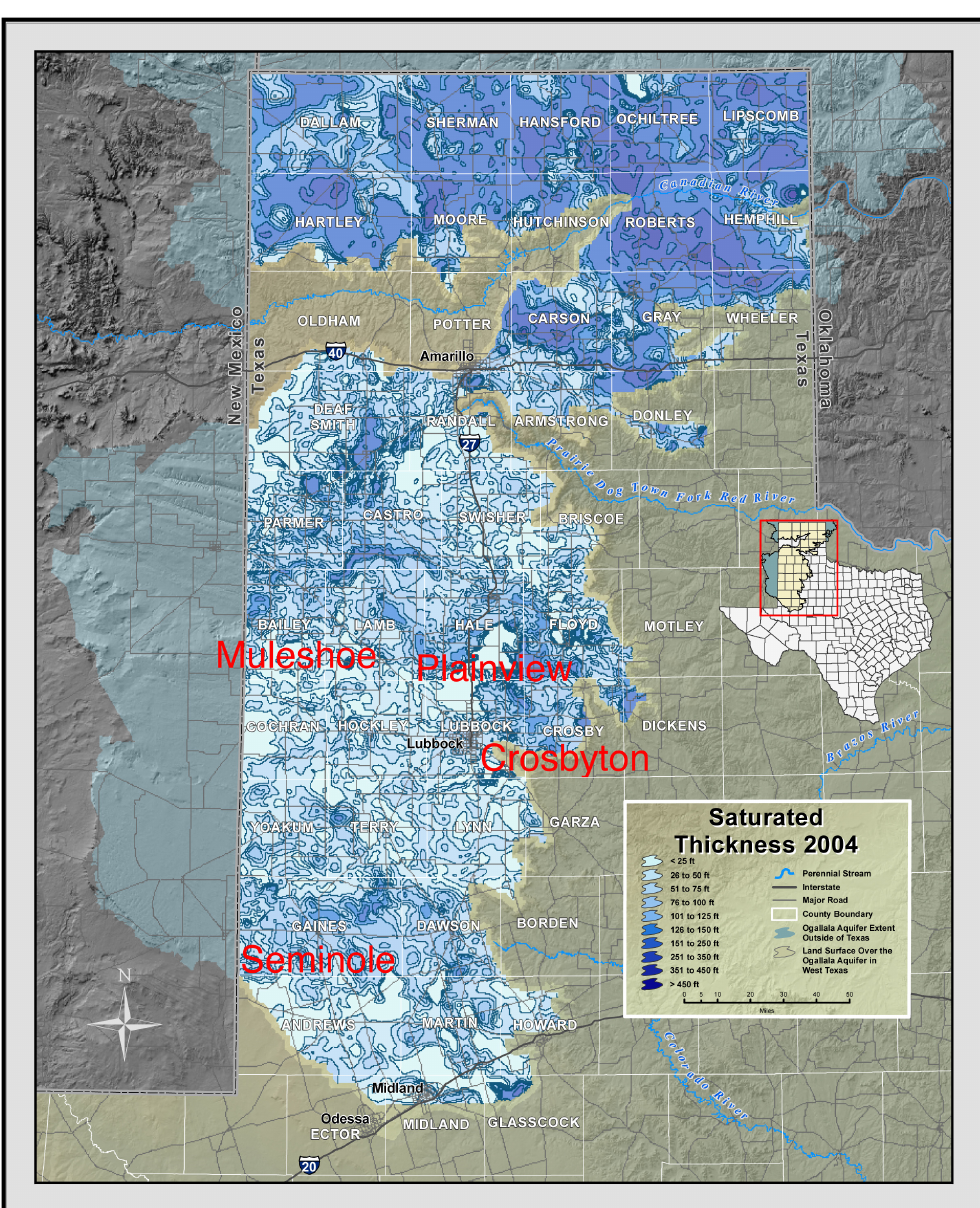
Figure 1. Location and saturated thickness of the four sites, Muleshoe (Bailey County), Seminole (Gaines County), Crosbyton (Crosby County) and Plainview (Hale County) used in our study [34].